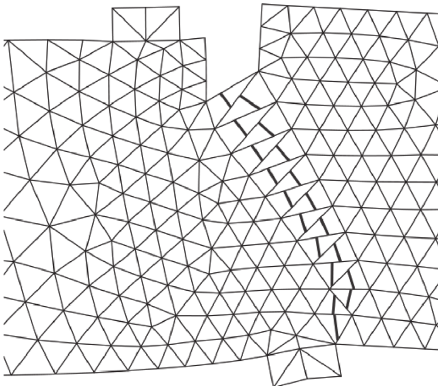
Figure 19: Crack pattern across elements.